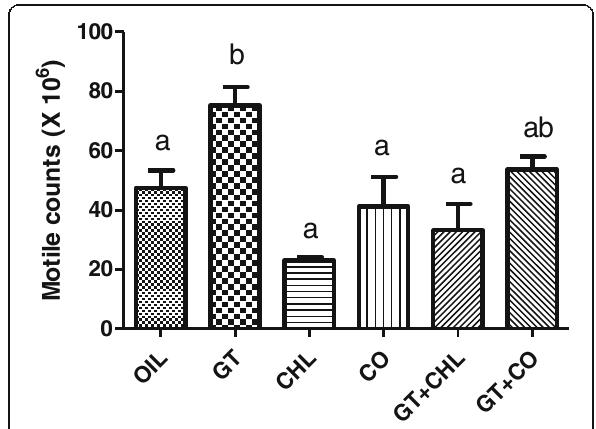
Fig. 2 Sperm motile counts (×10 6 ) in Wistar rats treated with mineral oil (OIL), green tea (GT), chlorpyrifos (CHL), extract of clove oil (CO), green tea and chlorpyrifos (GT+CHL), and green tea and extract of clove oil (GT+CO)